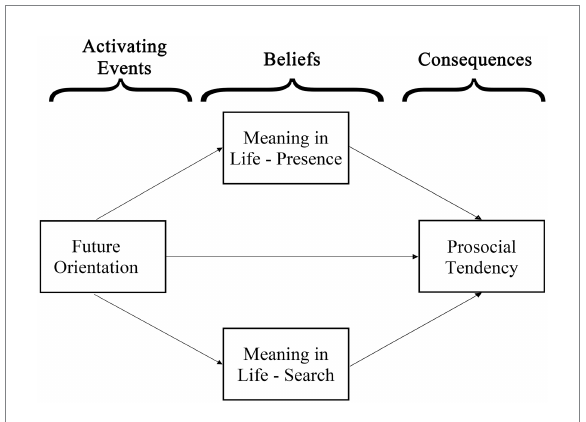
FIGURE 1 A hypothetical model for the relationships among major variables based on the ABC model (Ellis,